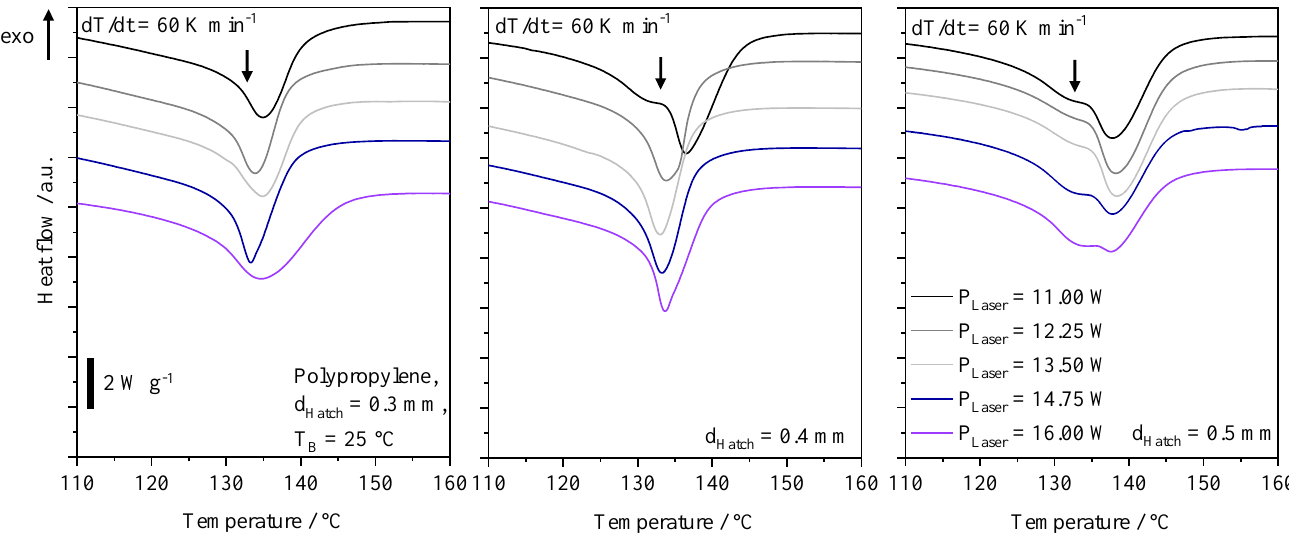
Figure 9. Differential calorimetric part properties in dependence on underlying spatial and scalar process properties; melting peak of recrystallized material indicated by black arrow.